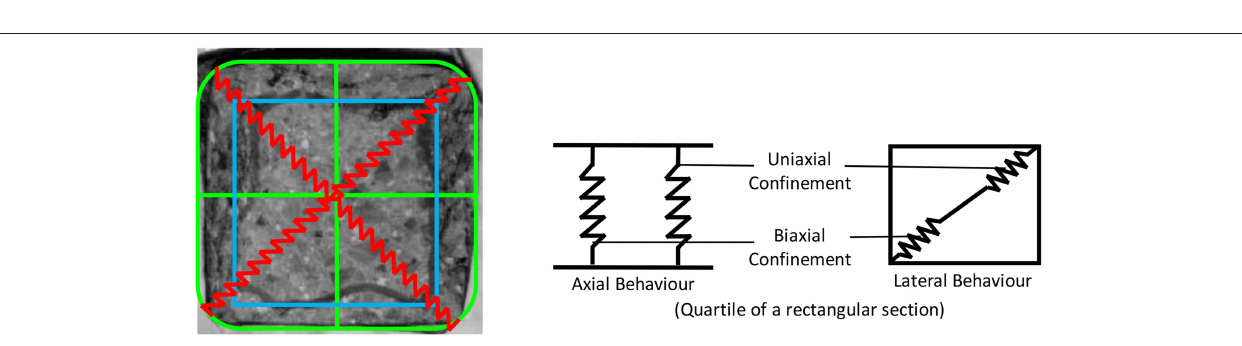
FIGURE 4 | Uniaxially and biaxially confined regions: (A) different thicknesses of FRP jacket, (B) different radii of rounded corner.